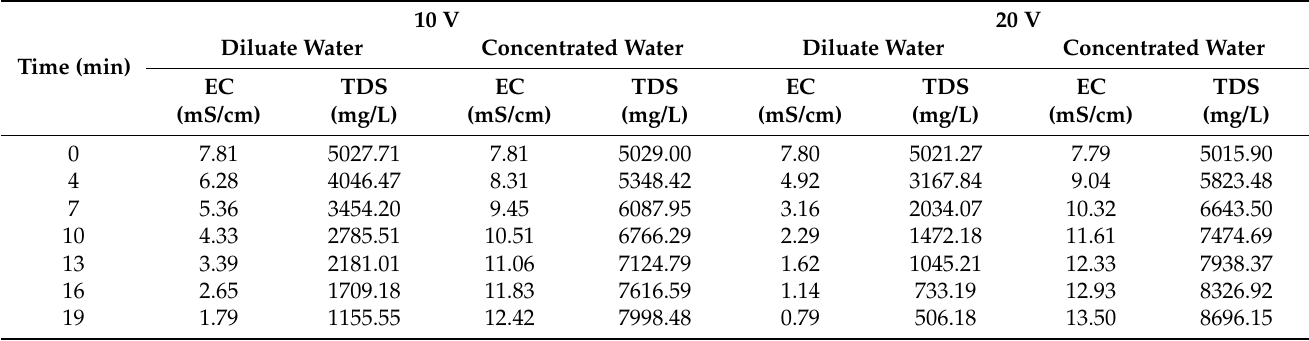
Table A6. Desalination results for the 5000 mg/L TDS sample at 35 ◦